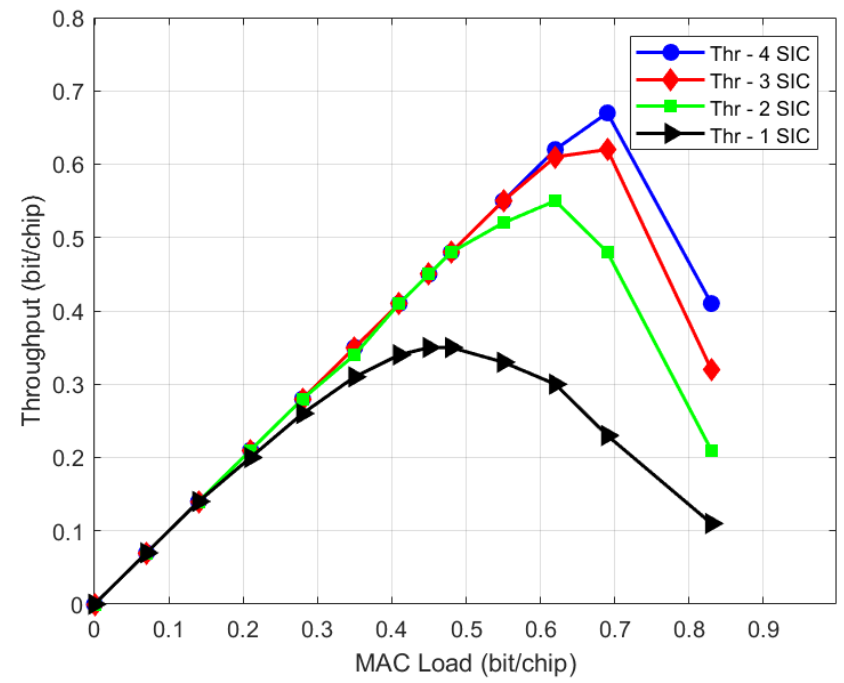
Figure 22. UC#3 IURA throughput performance per SIC iterations.